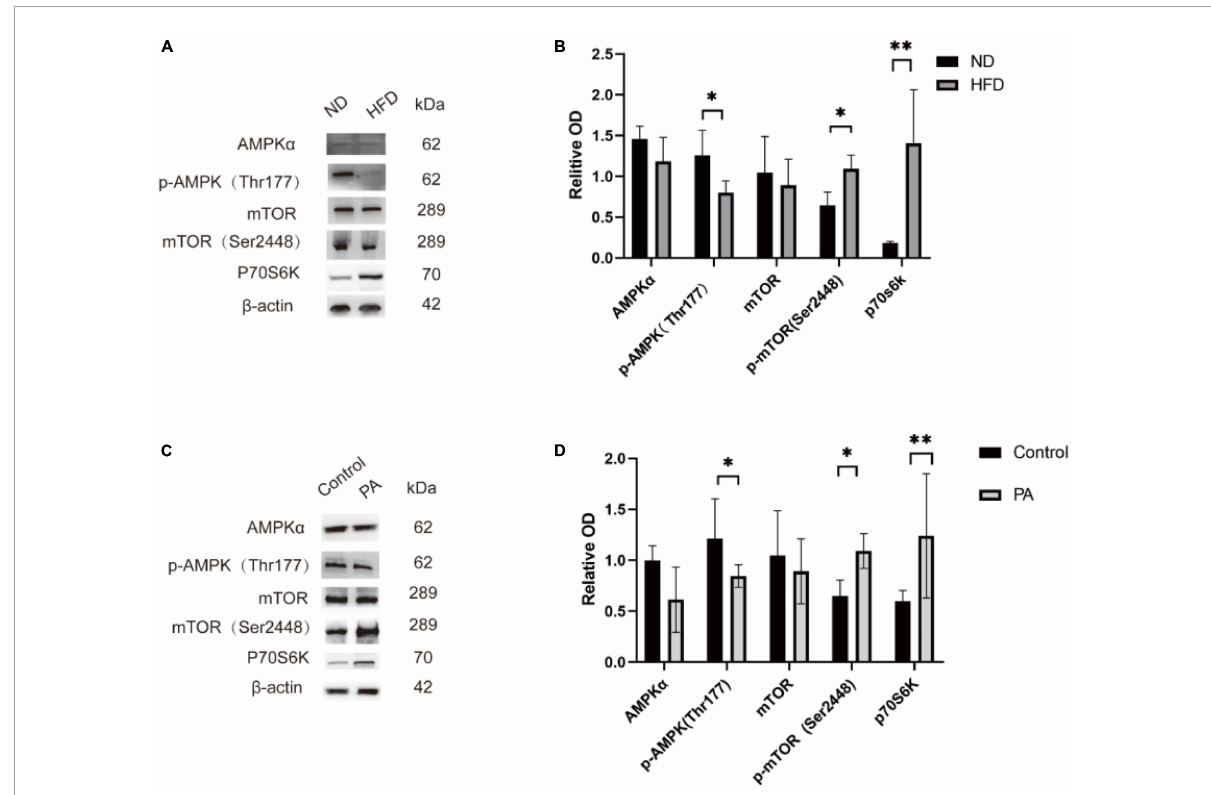
FIGURE7 Effect of high-fat diet on AMPK/mTOR/p70S6K pathway protein levels. Representative western blotting bands of mTOR, p-mTOR, AMPK, p-AMPK, and p70S6K in the hippocampus of the ND and HFD groups (shown in panel A) . Statistical results showed that a high-fat diet increased p-mTOR levels and the p-mTOR/mTOR ratio, decreased p-AMPK levels and the p-AMPK/AMPK ratio and decreased p70S6K in the hippocampus (ND, n = 4 mice; HFD, n = 4 mice) (shown in panel B) . BV2 cells treated with were done with PA medium (100 mM), and showed the same result (C,D) * p < 0.05, ** p <